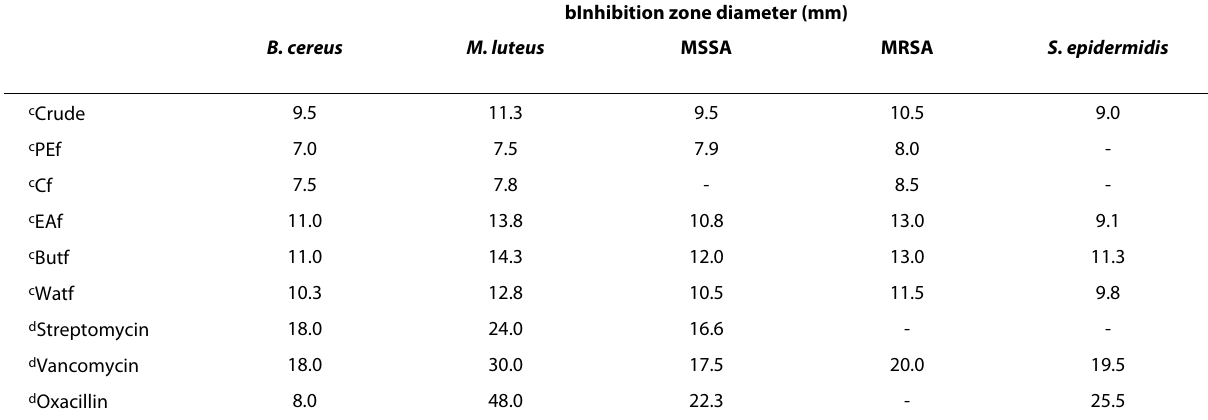
Table 3: Inhibition zone diameter of Blechnum orientale extracts and standard antibiotics against five Gram-positive bacteria